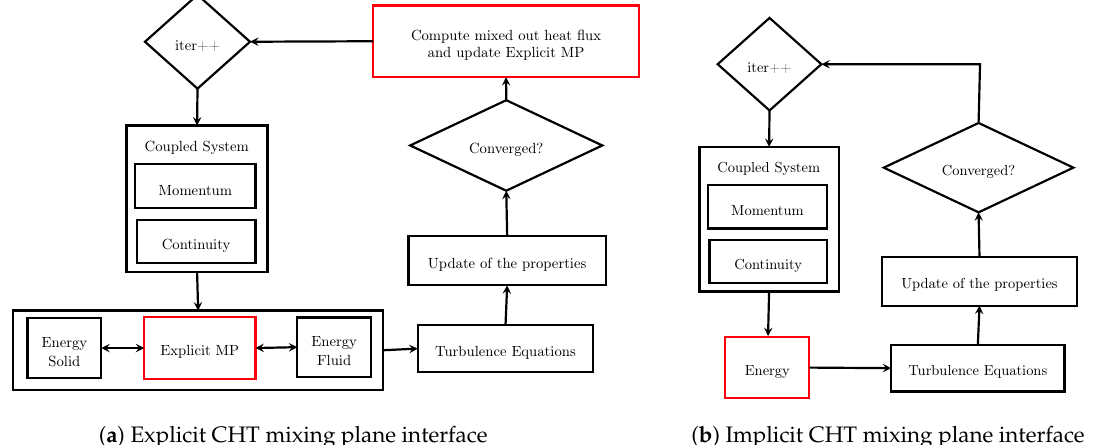
(b) Implicit CHT mixing plane interface Figure 4. Previous explicit and proposed implicit approach Figure 4. Previous explicit and proposed implicit approach Figure 4. Previous explicit and proposed implicit